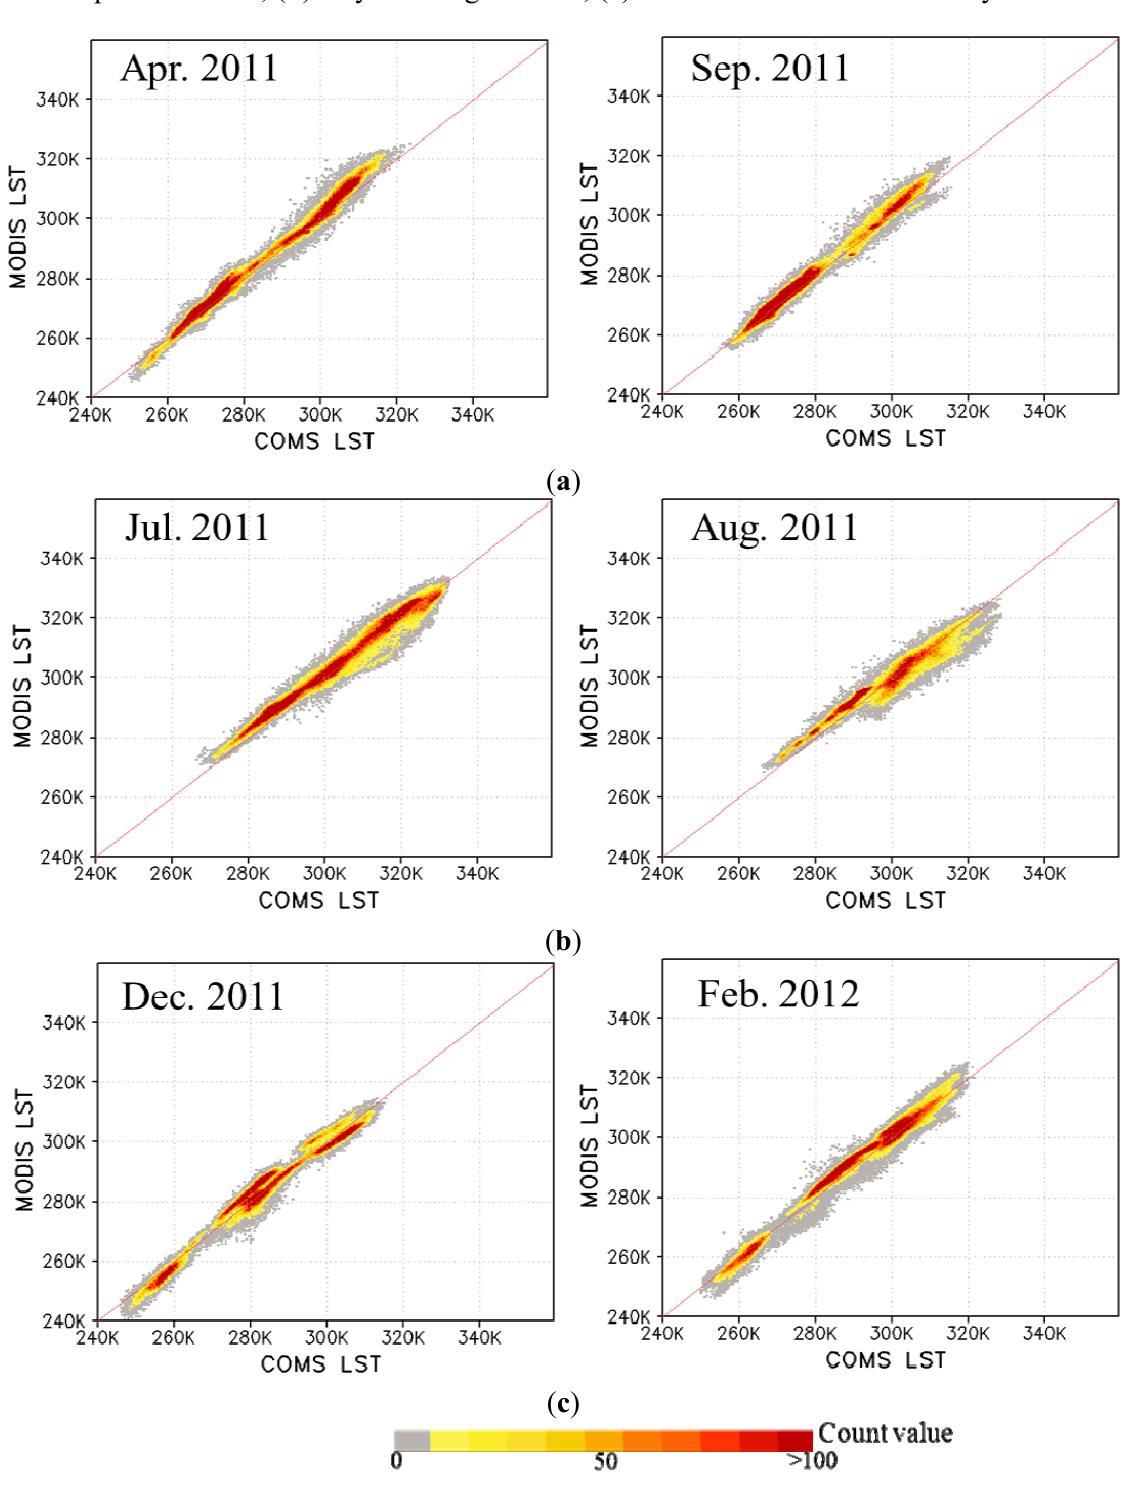
Figure 10. Scatter plot of COMS LST vs. MODIS LST for the selected months: ( a ) April and September 2011; ( b ) July and August 2011; ( c ) December 2011 and February